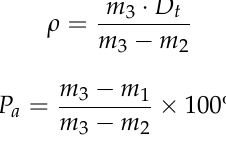
Figure 2. Schematic diagram of the preparation process of the C f /SiC-Al 2 O 3 composite. After PIP process, the SiC overcoating was deposited using CVD method [27],